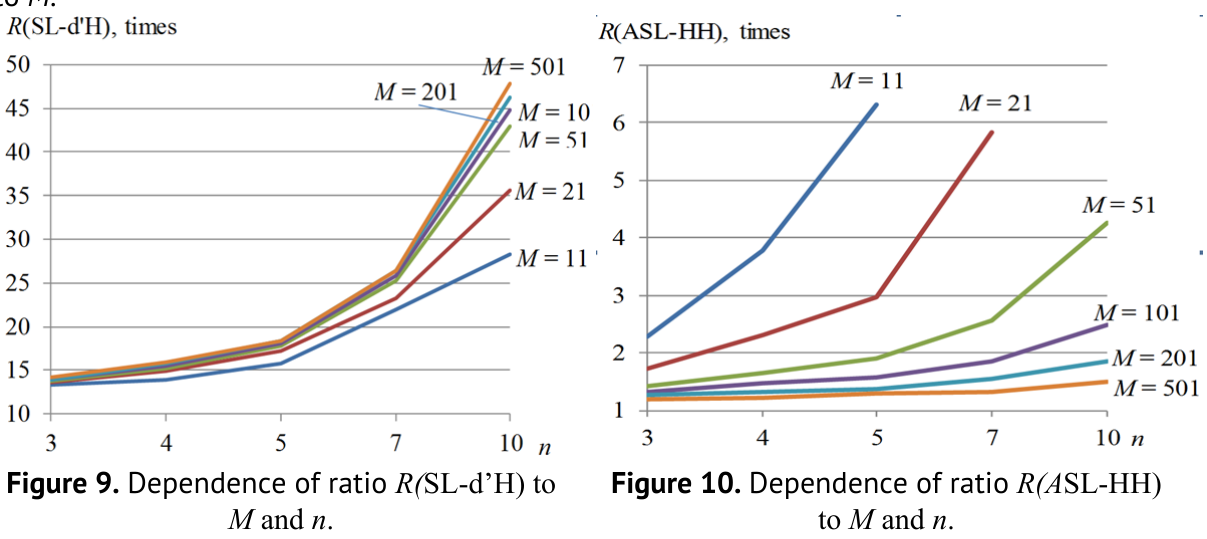
Figure 9. Dependence of ratio R( SL-d’H) to M and n .